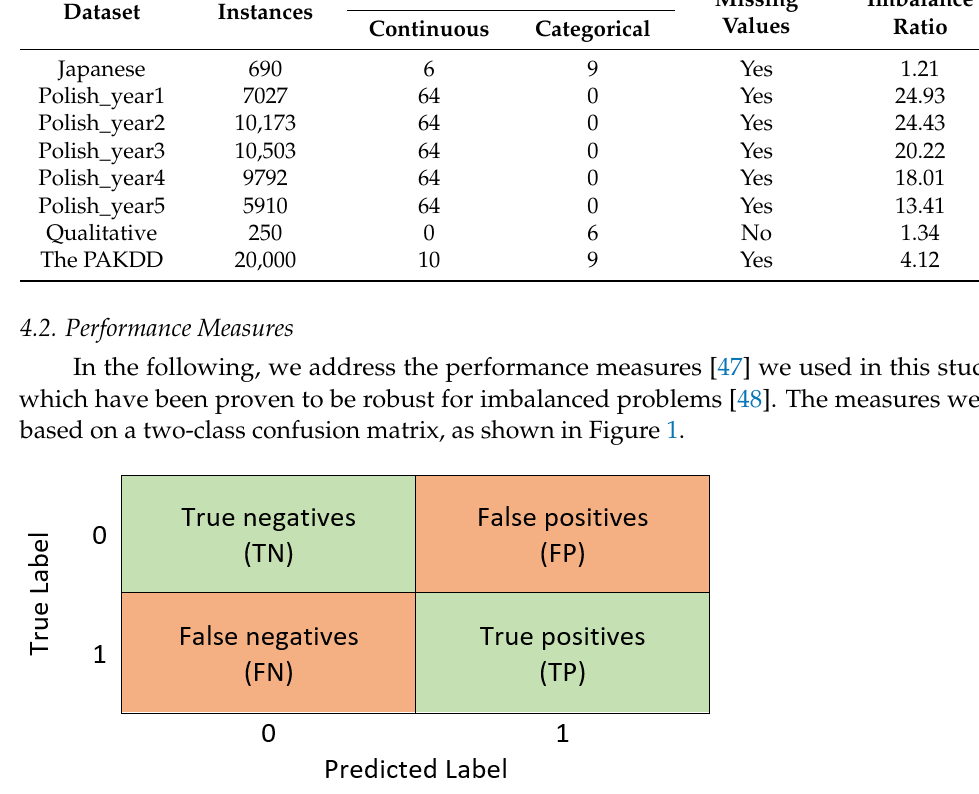
8 of 16 Table 2. Description of the datasets used. Dataset